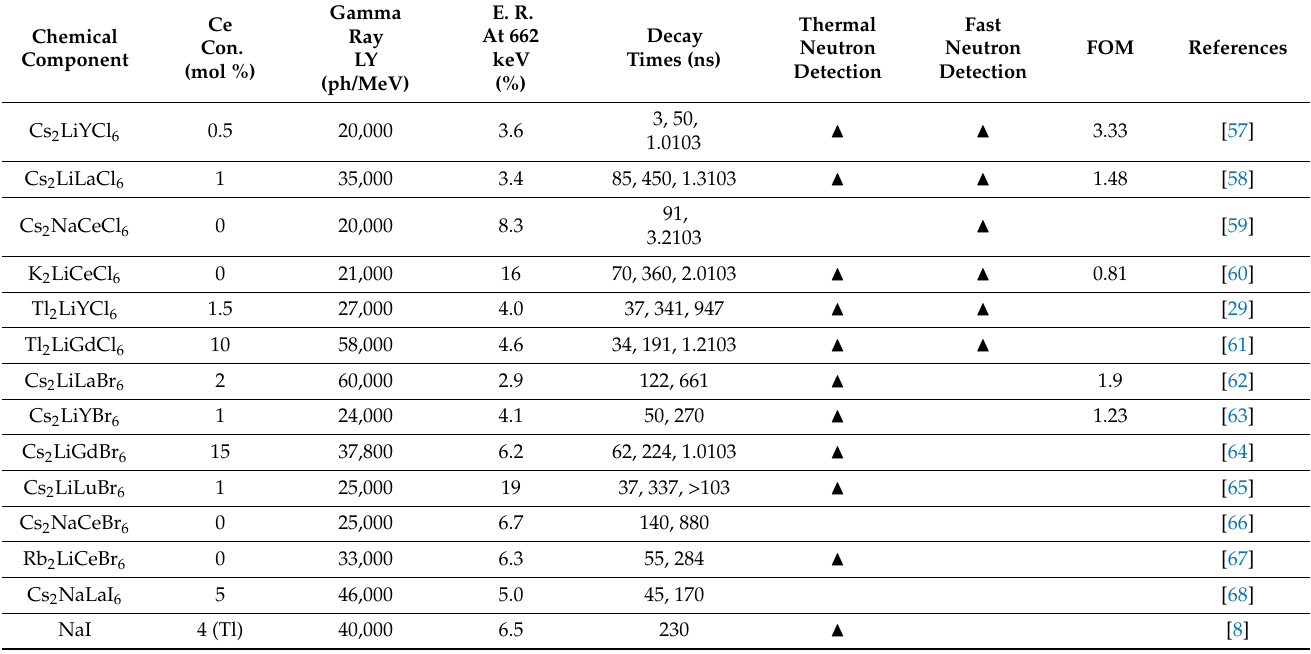
Table 2. Scintillation characteristics of various elpasolite crystals. FOM value was measured un- der 241 Am/Be source (4 MeV of average neutron energy). Ce Con: Ce concentration; E. R.: energy resolution. For comparison, the NaI:Tl crystal is also included [8,29,57–68]. Ce Chemical Component